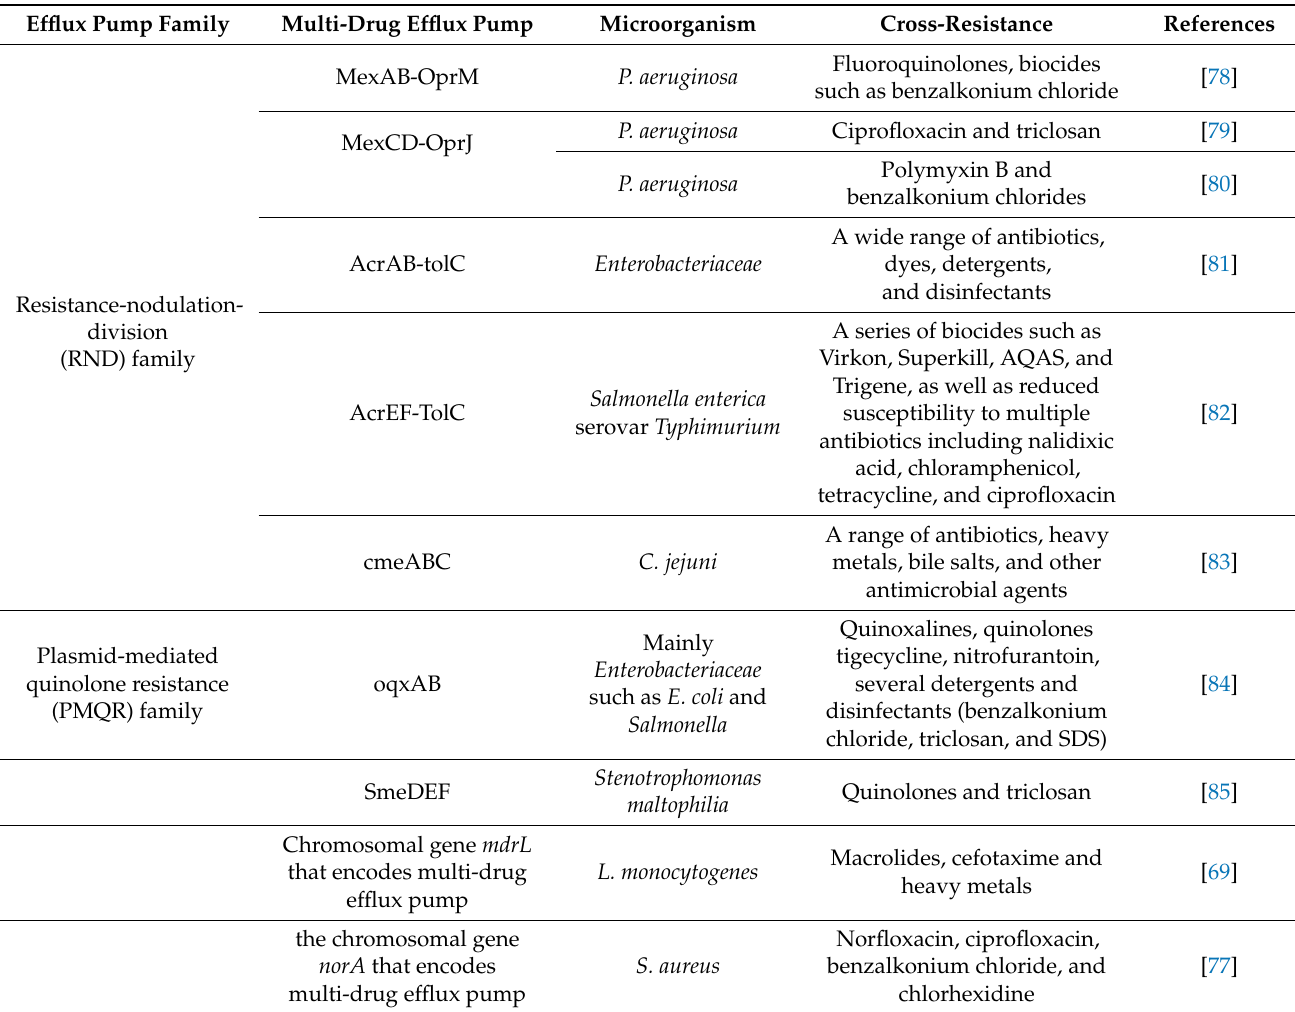
Table 4. A list of multi-drug efflux pumps that confer cross-resistance to antibiotics,